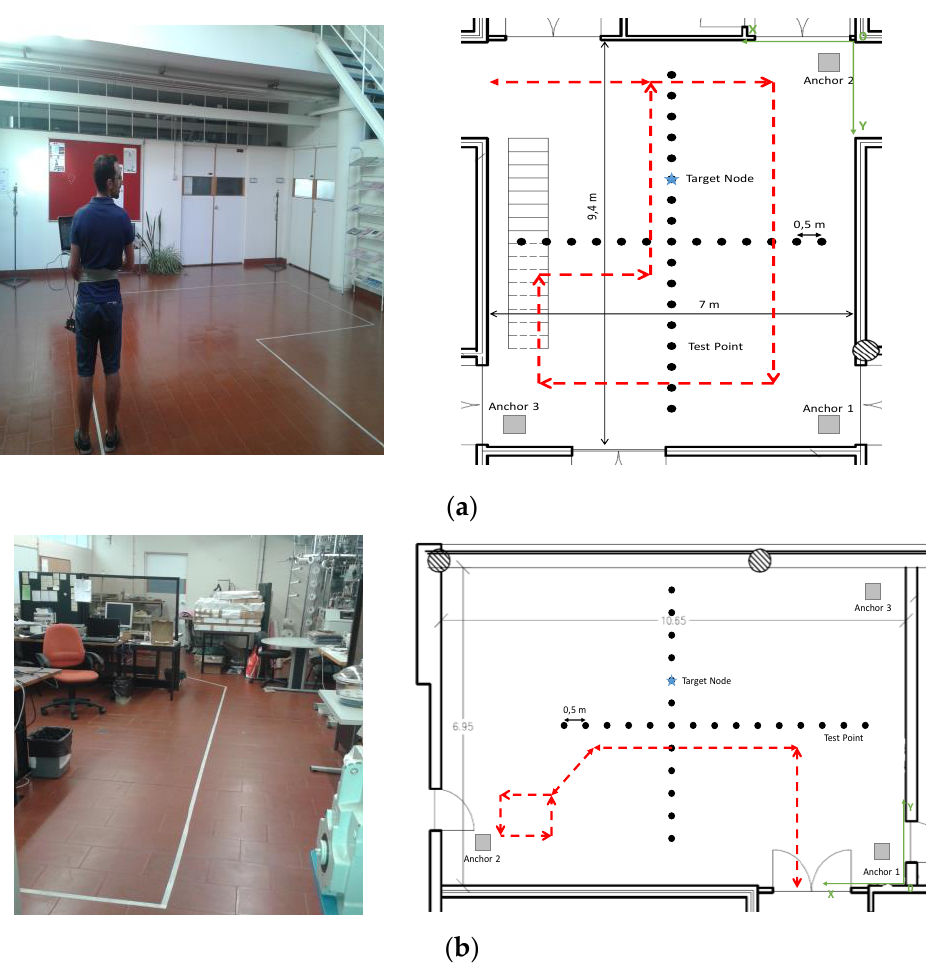
Figure 1. Illustration of the experimental setup in: ( a ) atrium; ( b ) lab.